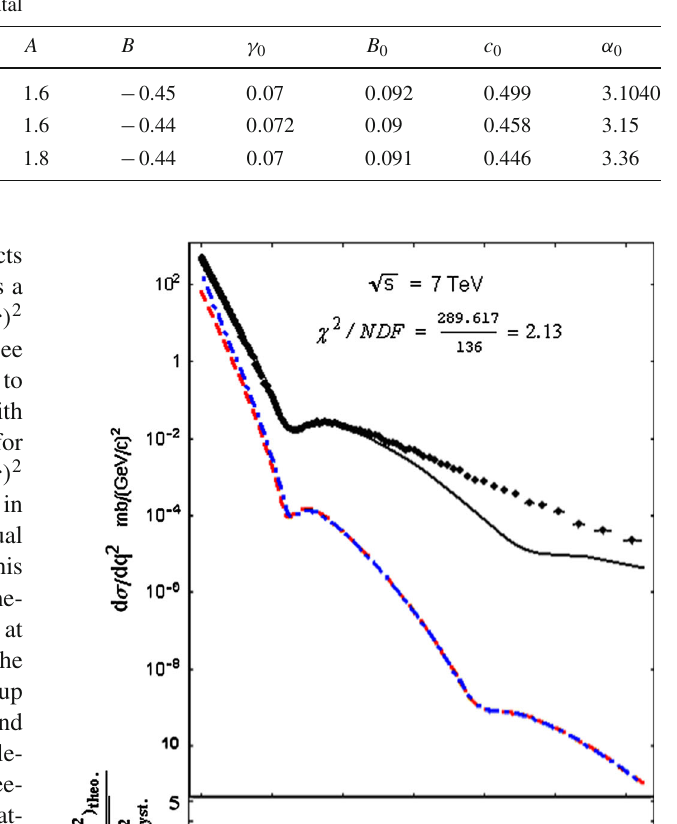
value of σ in ( s ) of proton–proton scattering are taken from [1,3,5] for 7, 8 and 13 TeV, respectively